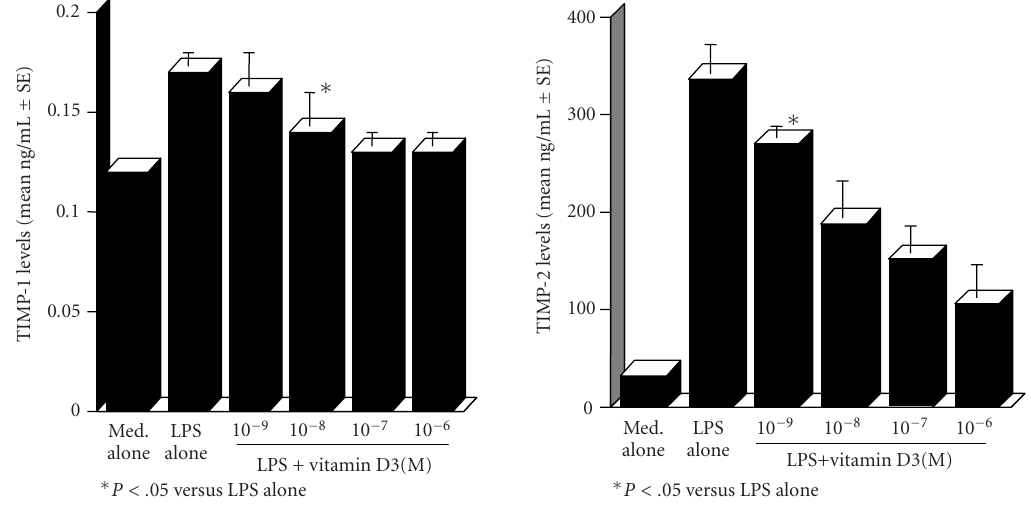
Figure 2. Suppressive activity of vitamin D3 on TIMP-1 and TIMP-2 production from keratinocytes in vitro. Details are shown in the legend of Figure 1.